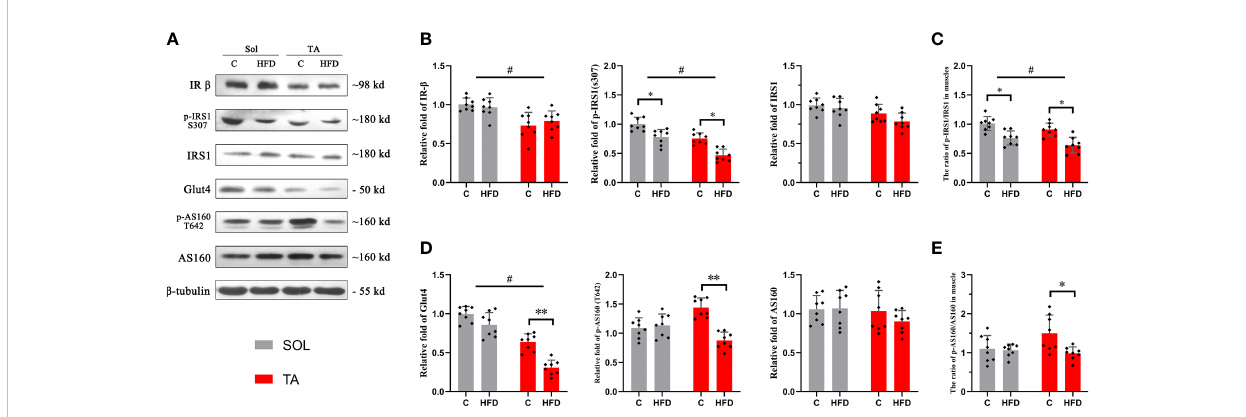
FIGURE 2 Insulin and glucose transport in fast- and slow-twitch muscles after HFD intervention. (A) The original western blotting results of phosphorylated IRS1 (S307), IRS1, IR- b , phosphorylated AS160 (T642), AS160 and Glut4 in muscle lysates. (B) Quanti fi cation of relative expression of p-IRS1 (S307), IRS1 and IR- b protein in each group. (C) The ratio of the relative expression of p-IRS1 and total IRS1. (D) Quanti fi cation of relative expression of the p-AS160 (T642), AS160 and Glut4 protein in each group. (E) The ratio of the relative expression of p-IRS1/IRS1. (*p<0.05; **p<0.01; and #p<0.05 when comparison was conducted between muscles; n=8 for each